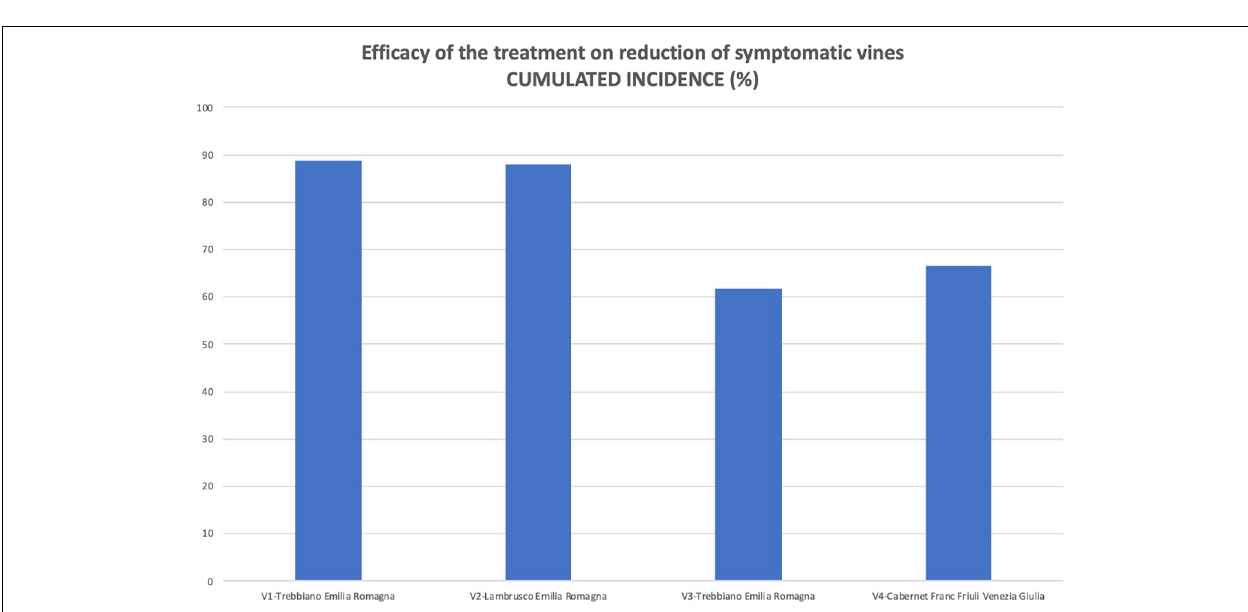
FIGURE 8 | The efficacy of wound protection by the Trichoderma commercial product in reducing the number of symptomatic vines was calculated on the final number of vines that showed symptoms at least once during the whole survey time (cumulated incidence at the end of the trial).